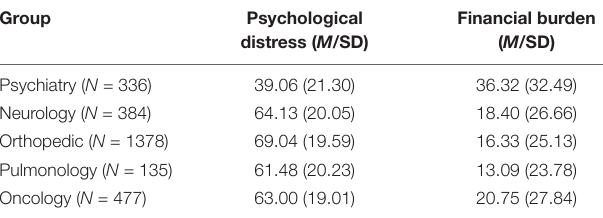
TABLE 2 | Psychological distress (EF scale) in different patient